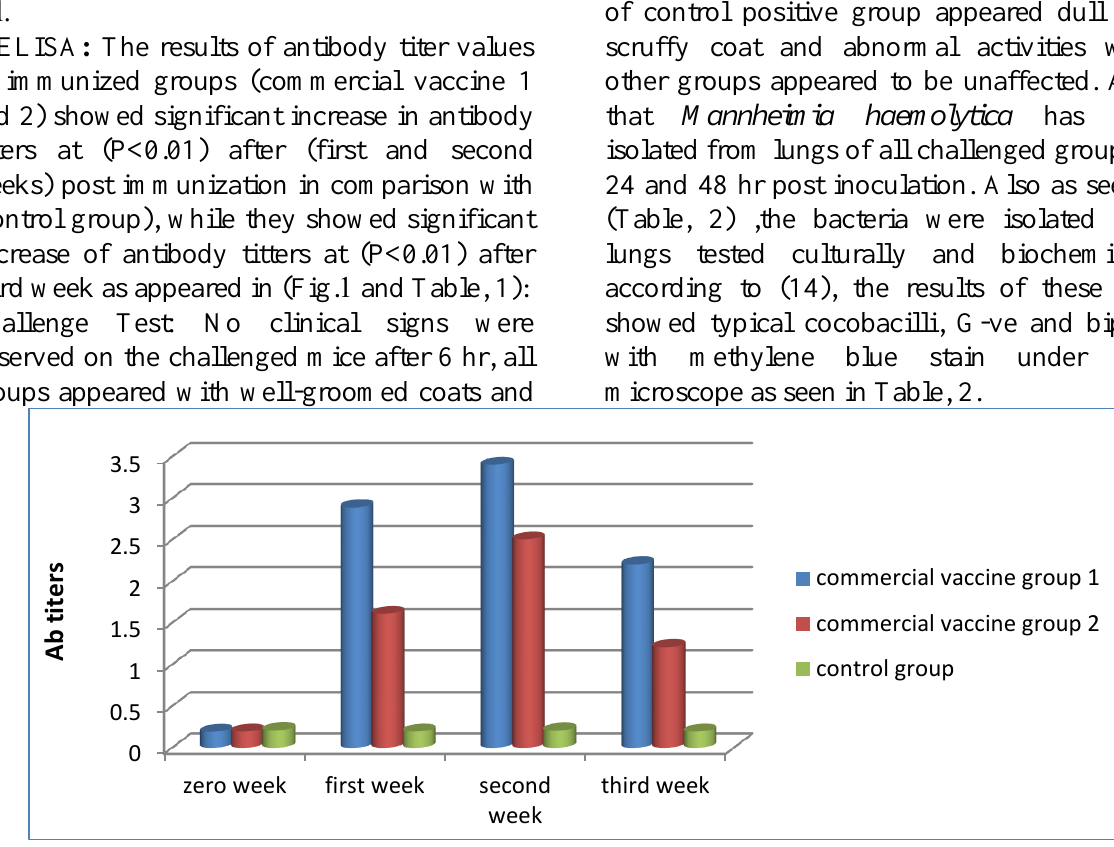
Figure, 1: Antibody titers in the immunized and control groups in ELISA test. Table, 1: Antibody titers in the immunized and control groups in ELISA test. The group